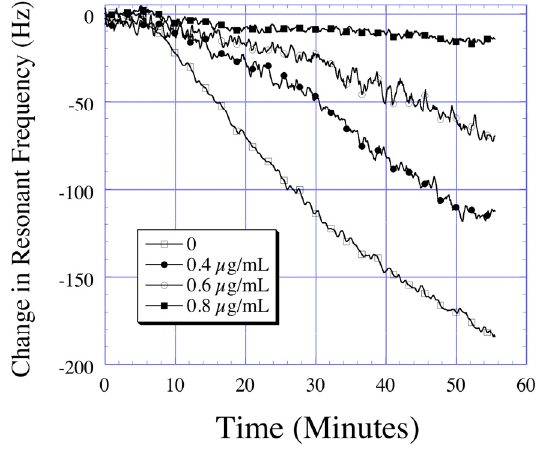
Figure 26. Shift in the resonance frequency with time for a PEG coated sensor as a function of different avidin concentrations. Reprinted with permission from